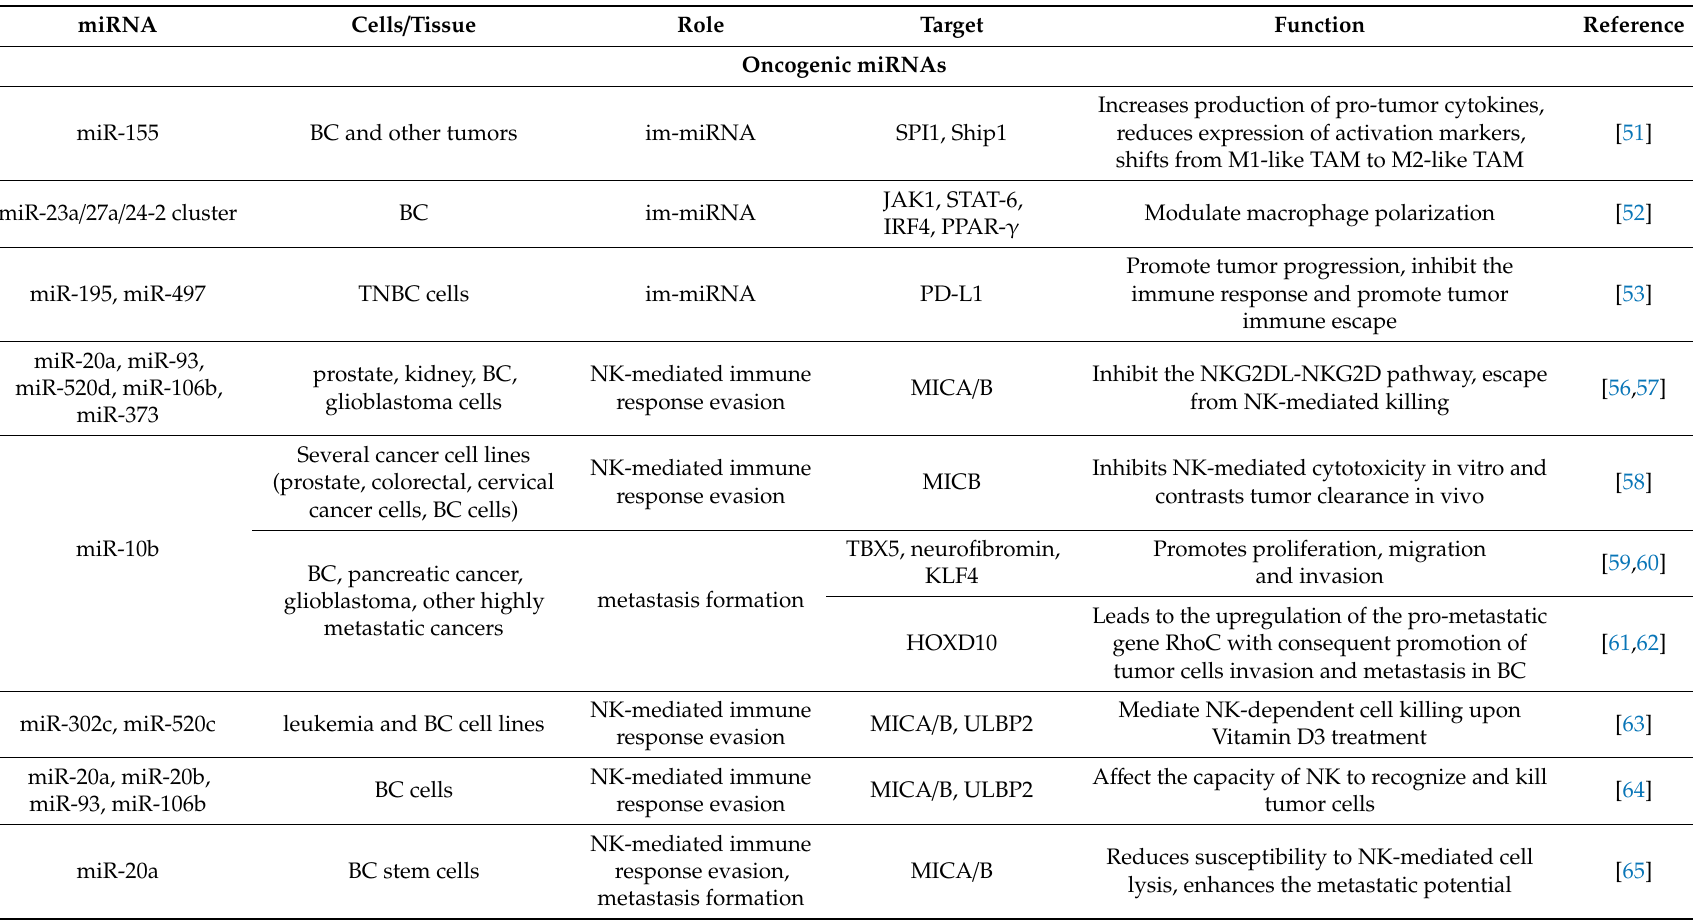
Table 1. Oncogenic miRNAs and tumor-suppressive miRNAs and their role in breast cancer